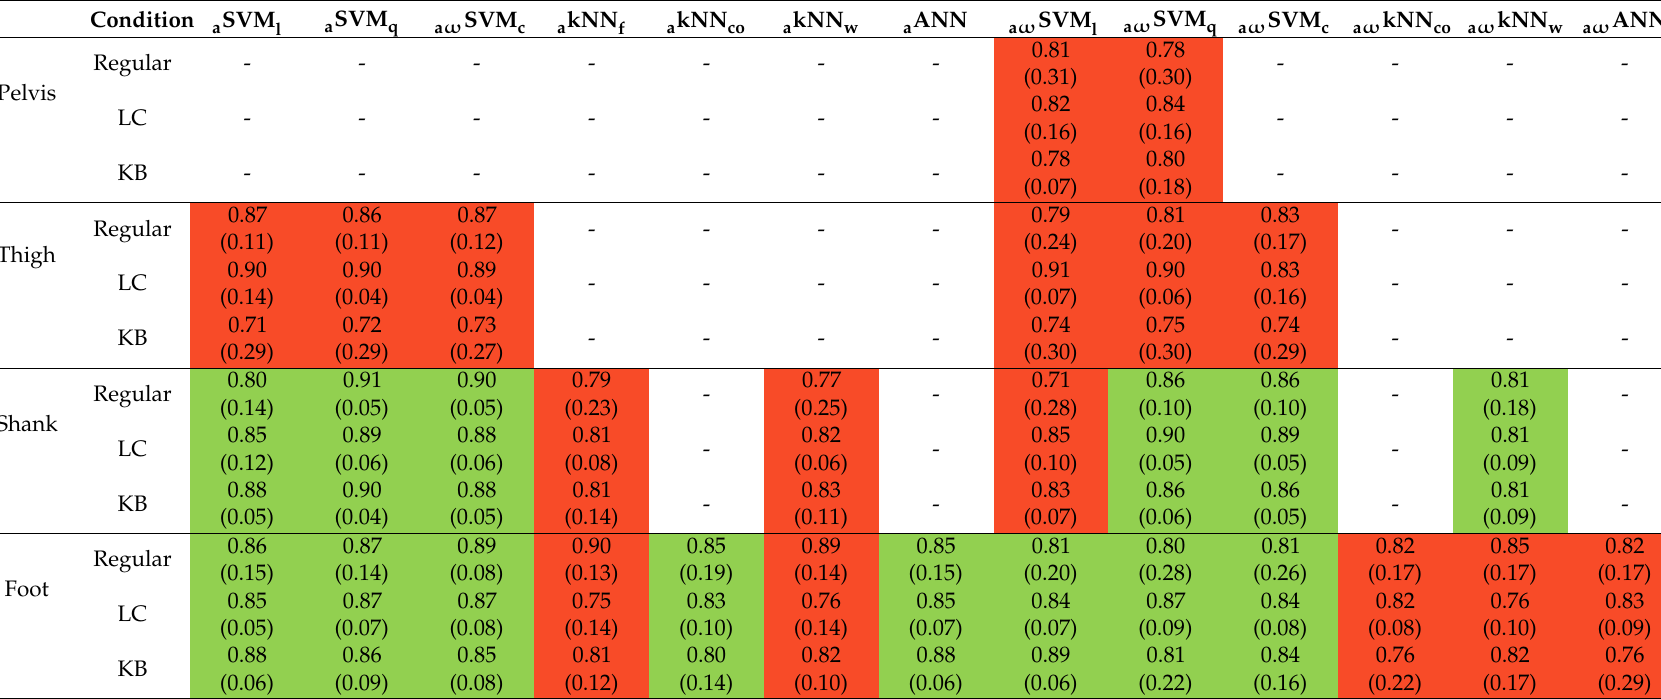
Table 4. Mean and standard deviation values of recall for the classifiers that passed the first selection criterion. The green cells represent classifiers that passed the second selection criterion; the others are highlighted in red. “-“ indicates a classifier that did not pass previous